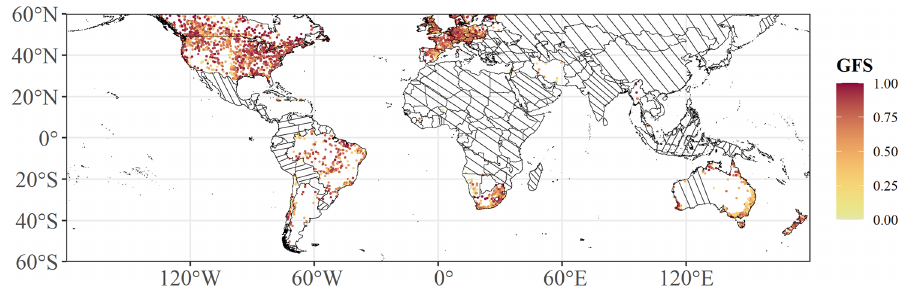
Figure 12. The GFS of 3408 discharge sites around the world. Hatching denotes no